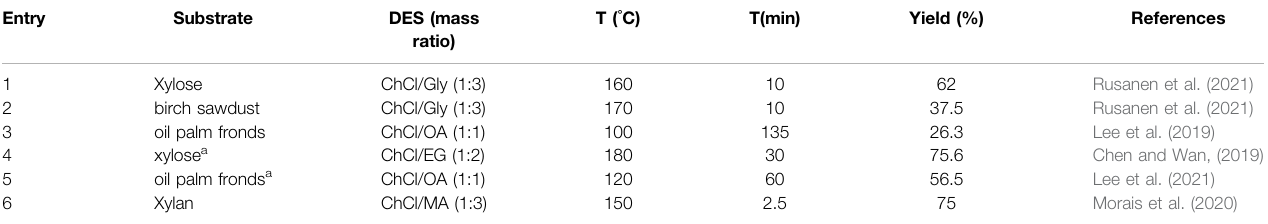
TABLE 3 | Adding water in the DES system for furfural production.